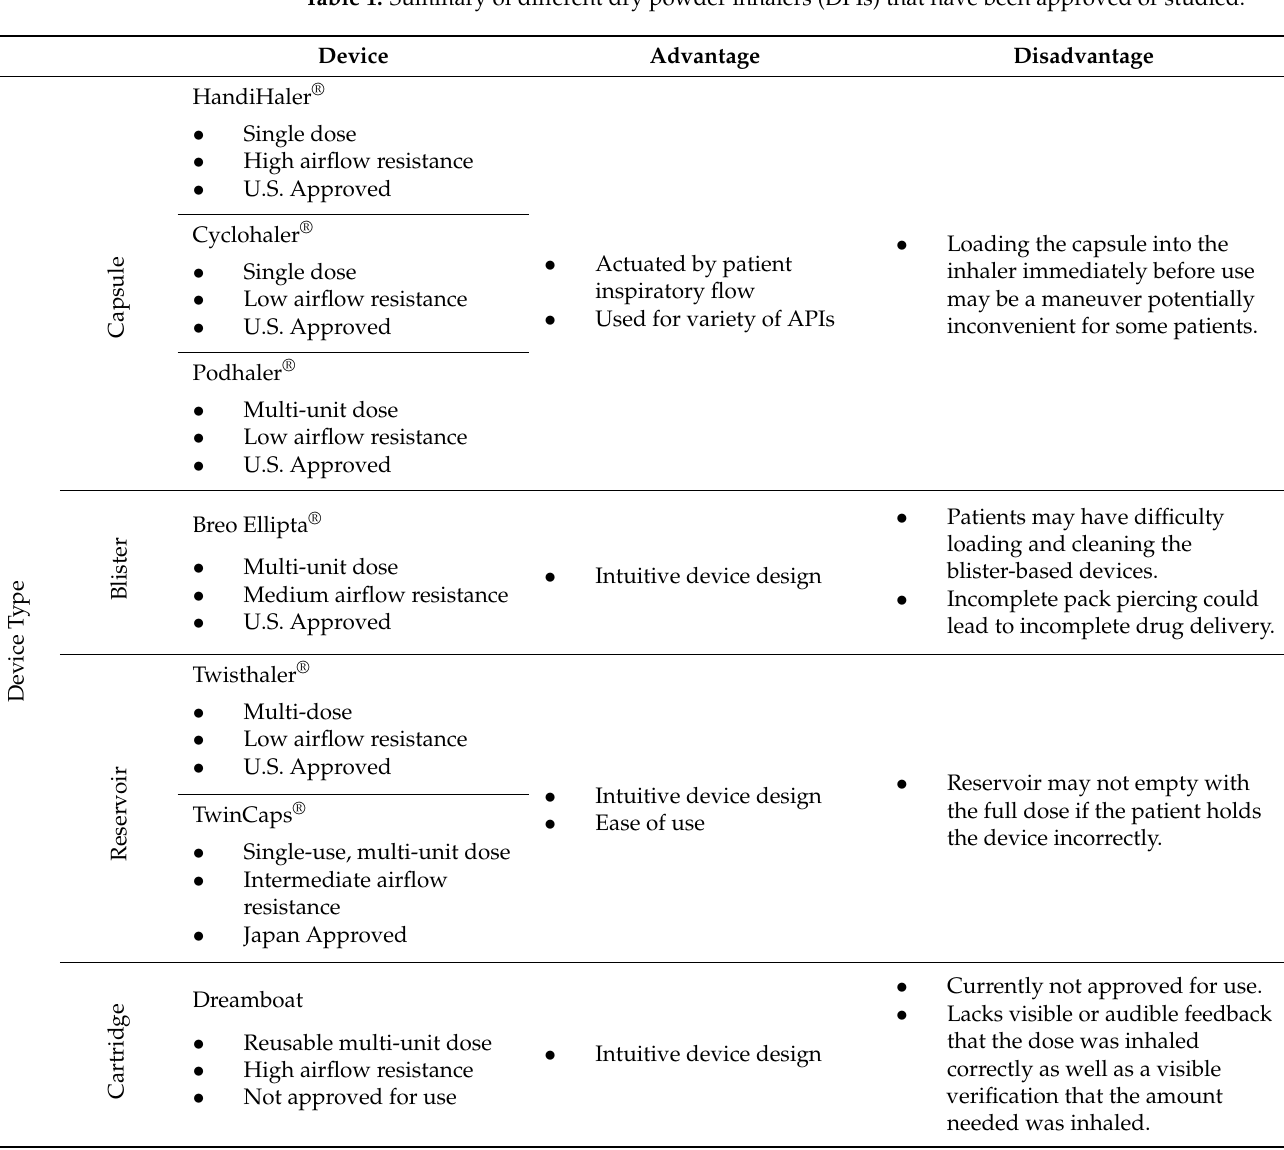
Table 1. Summary of different dry powder inhalers (DPIs) that have been approved or